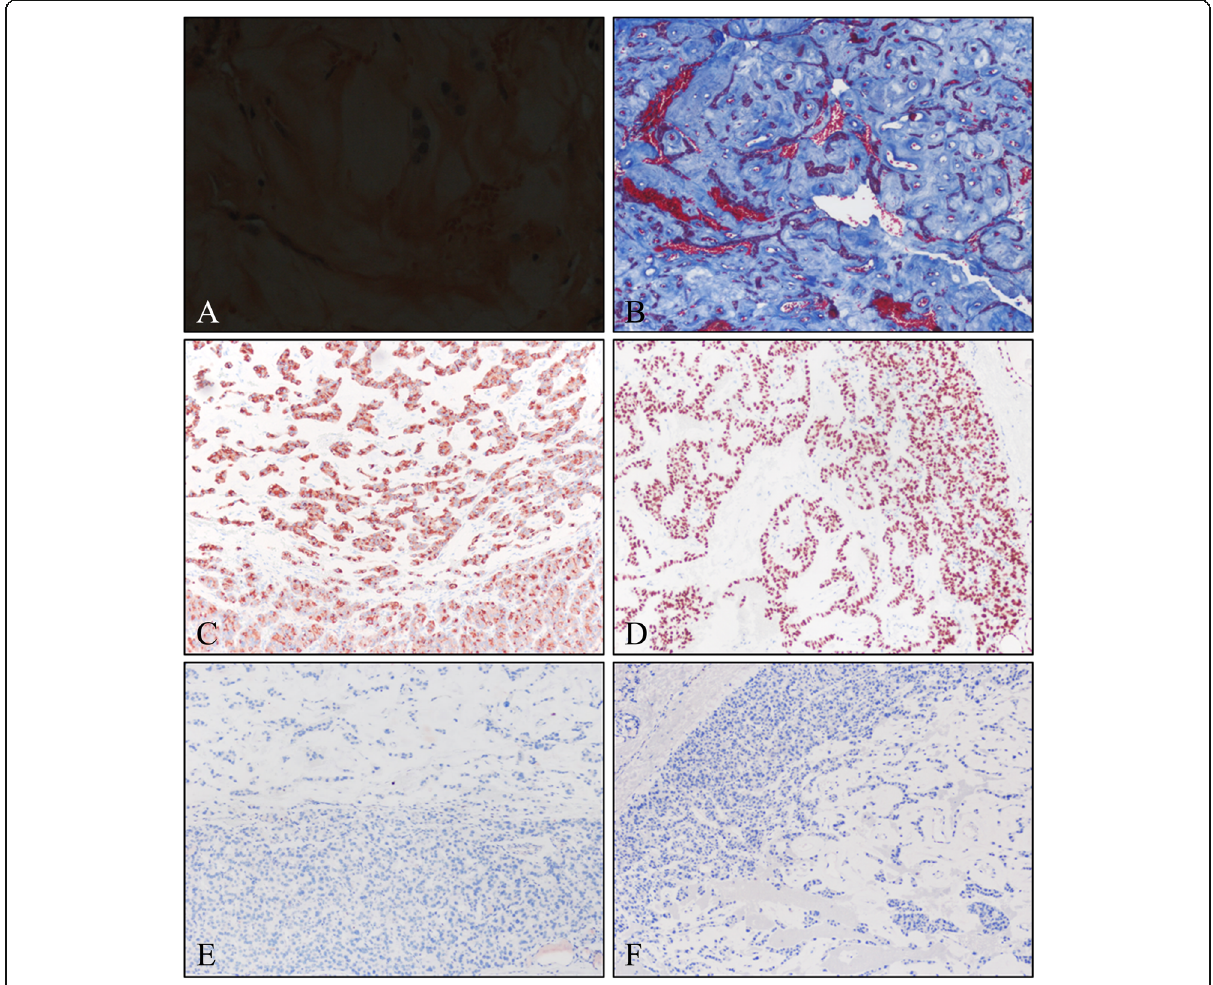
Fig. 4 Special stain and immunohistochemical features of the mass. a Congo Red staining of the section did not reveal any apple-green birefringence under polarized light microscopy (original magnification, × 400). b The homogenous eosinophilic materials stained blue with Masson trichrome stain (original magnification, × 100). The tumor cells showing immunoreactivity for thyroglobulin ( c ); original magnification, × 100) and TTF-1 ( d ); original magnification, × 100). The tumor cells did not express immunoreactivity for synaptophysin ( e ); original magnification, × 100) or calcitonin ( f ); original magnification, ×